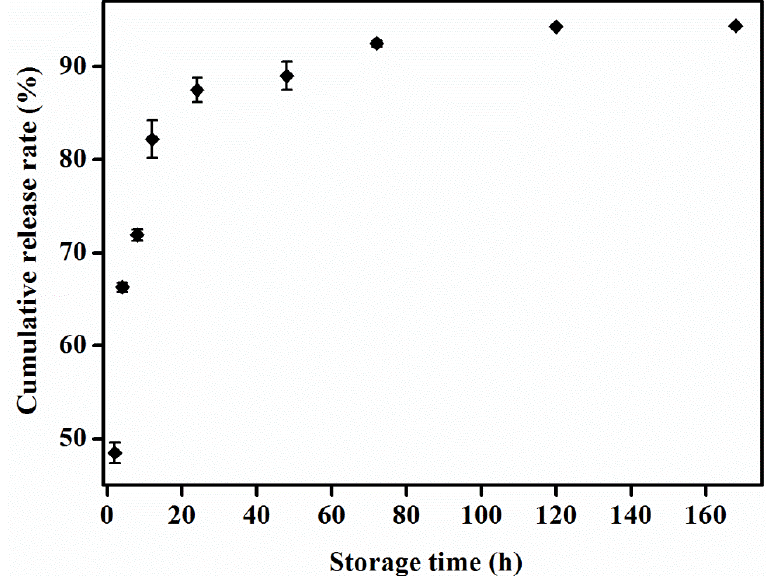
Figure 2. Cumulative release rate of chitosan–cinnamon essential oil microcapsules during in vitro release. Error bars represent the standard deviations of three replicates.